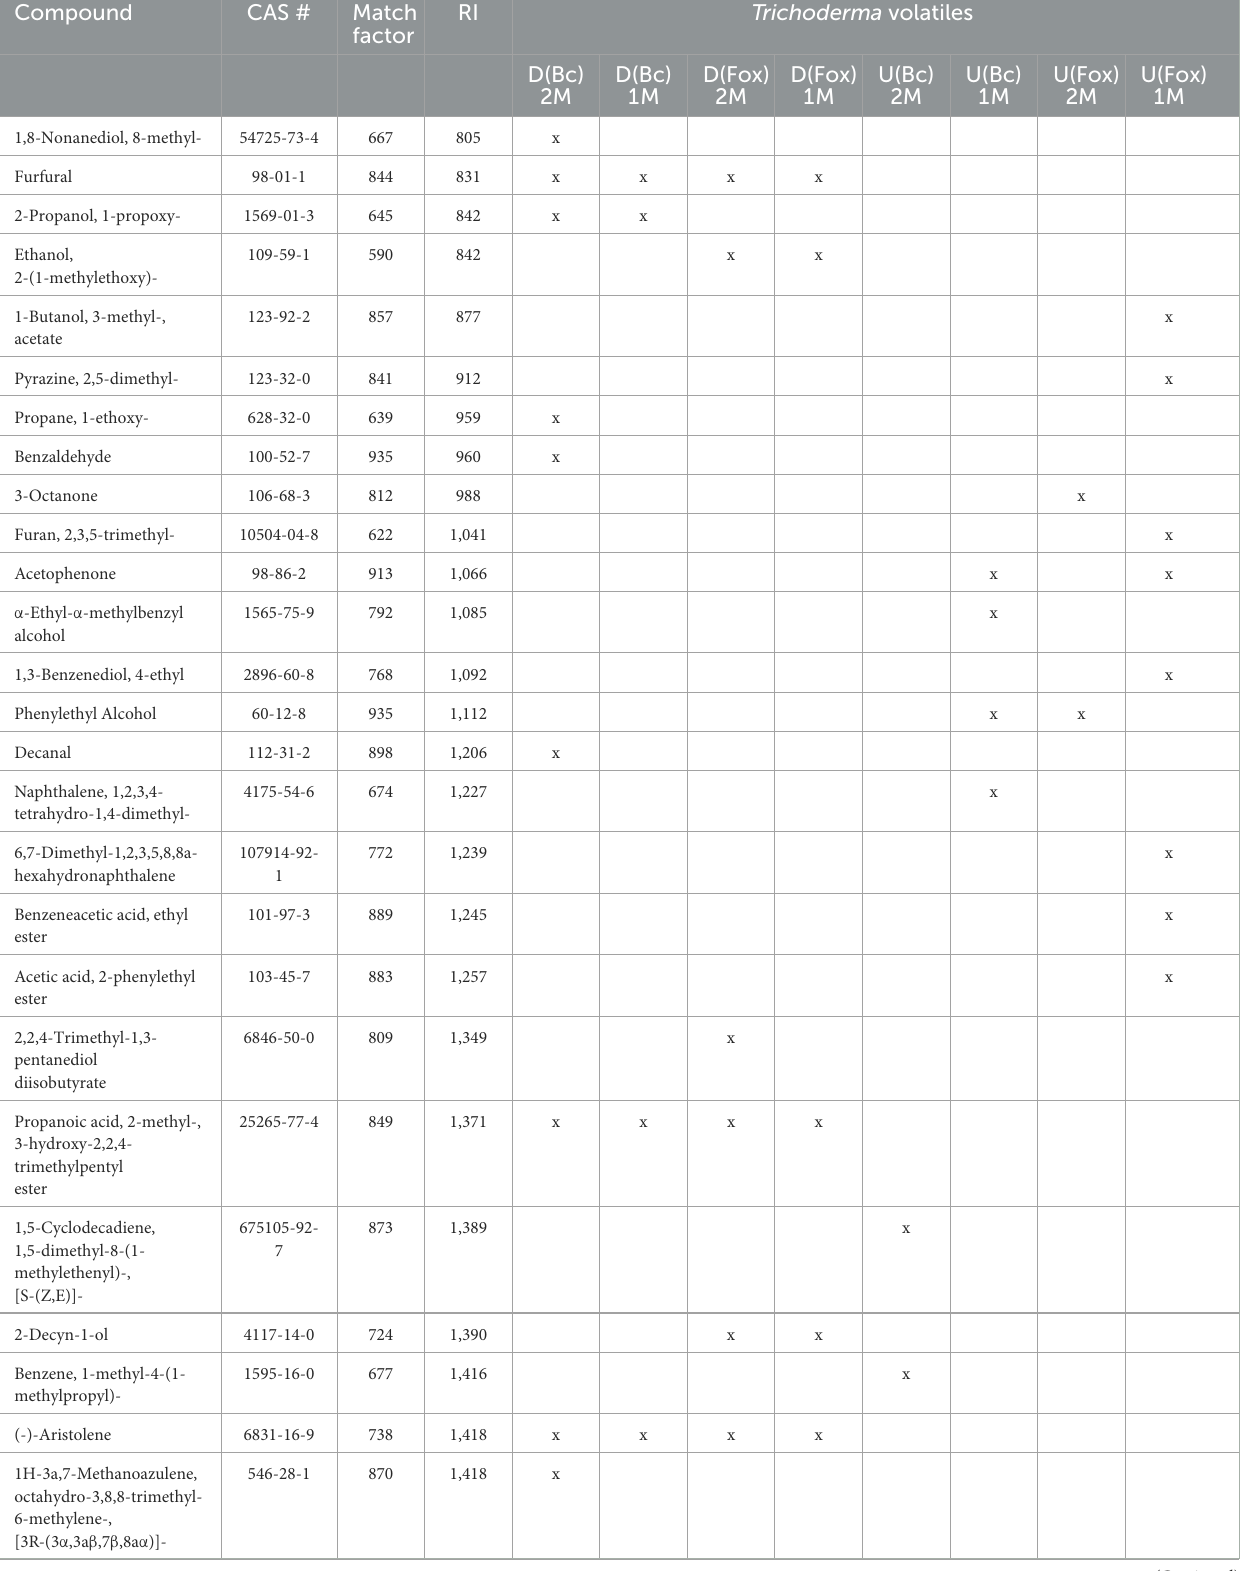
TABLE 4 Comparative list of compounds with significantly modified abundance after exposure to phytopathogenic fungi using the dual microcosm setup (2M) or the single microcosm setup (1M). Compound CAS # Match factor